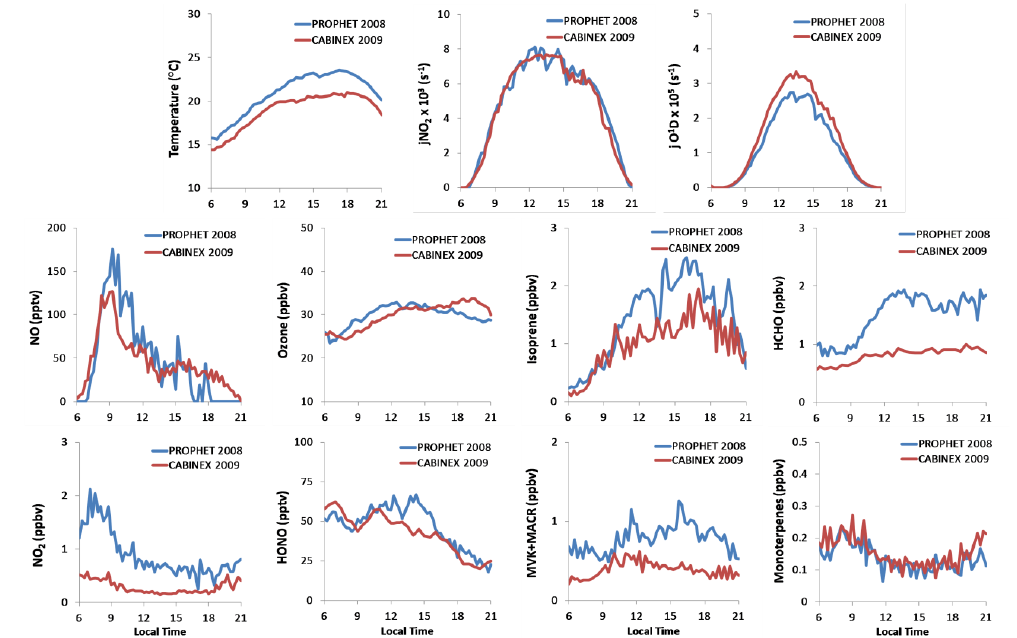
Figure 3 : Diel median values of several species measured from above canopy during PROPHET 2008 (blue) and CABINEX 2009 (red). Constrained model inputs based on overlap of measurements are shown in the Supplementary Material.